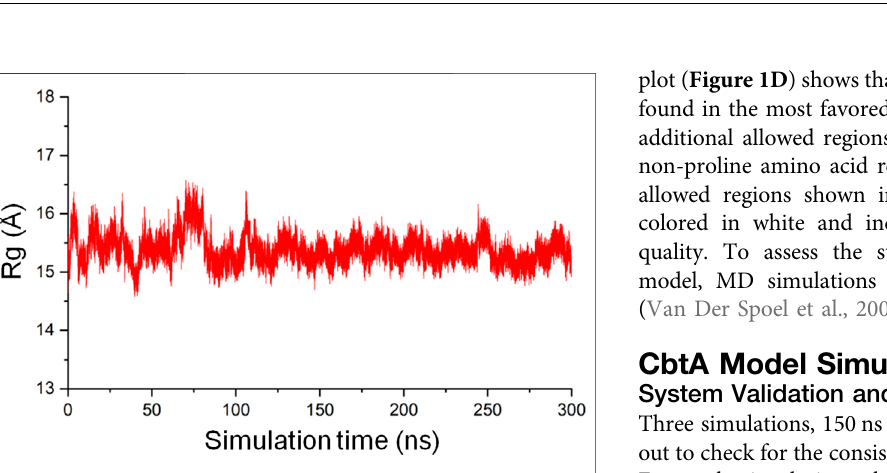
FIGURE4| Secondarystructure typeassignedtotheaminoacidresidues ofCbtA.White, red,black, green, yellow,blue, purple,and gray colorsrepresent coil, β - sheet, β -bridge, bend, turn, α -helix, 5-helix, and 3-helix, respectively.